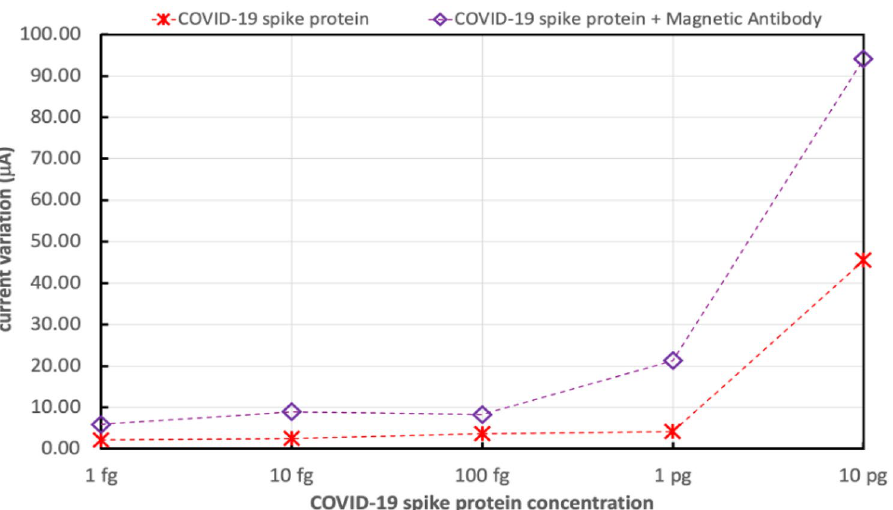
Figure 14. Variations in the electrical drain current of FET biosensor decorated with bimetallic Pd/Pt nanoparticles is due to the different concentrations of COVID-19 spike antigen without and with the addition of magnetic